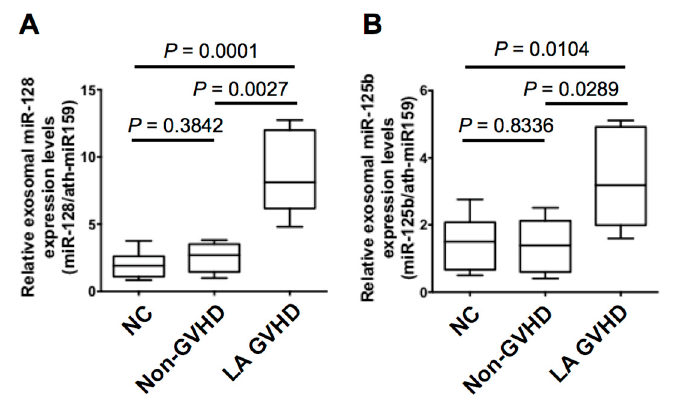
Figure 4. ( A ) The expression level of miR-128 was significantly upregulated in the exosomes of late-onset acute GVHD when compared with that in non-GVHD ( p = 0.0027) and in healthy subjects ( p < 0.005). ( B ) The expression level of mir-125b was significantly upregulated in the exosomes of late-onset acute GVHD when compared with that in non-GVHD ( p = 0.0289) and in healthy subjects ( p = 0.0104).